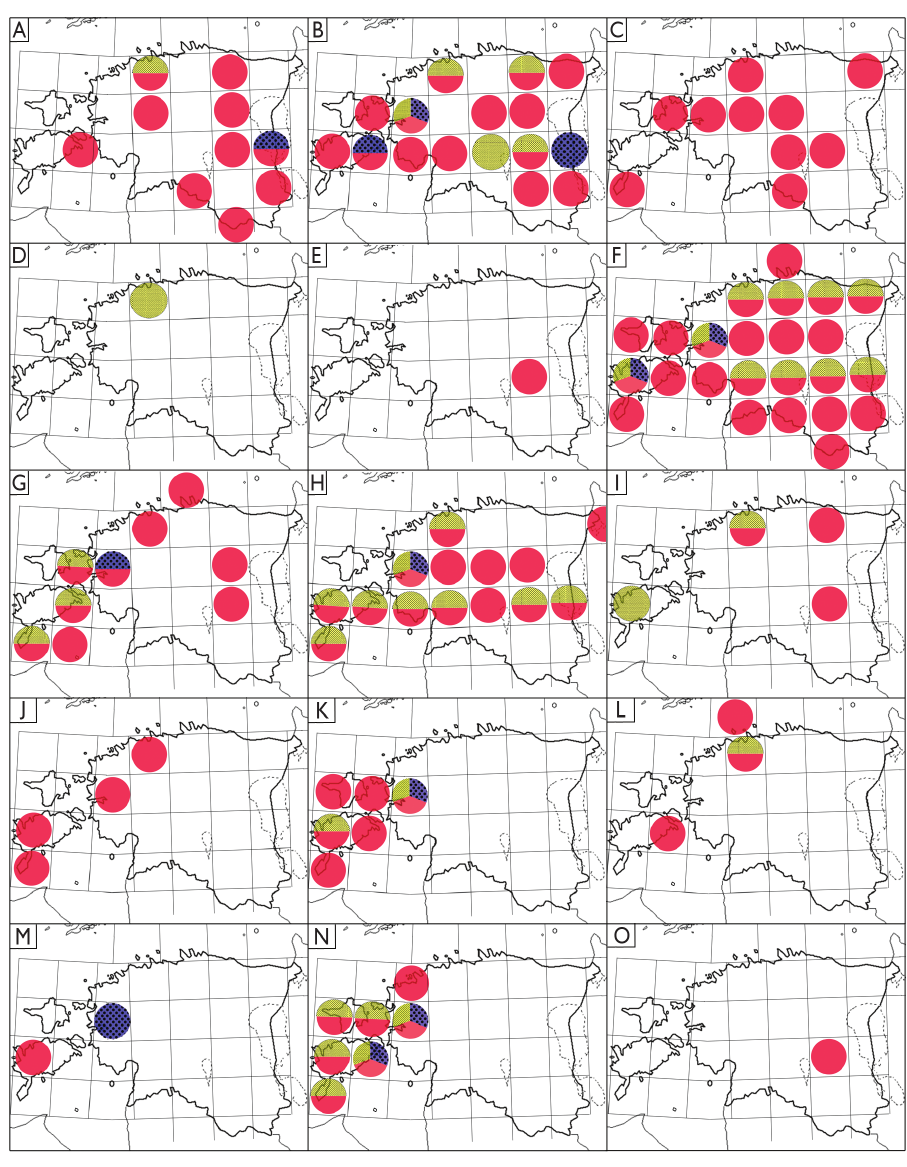
Figure 5. Distribution of Estonian Oniscidea. Red denotes studied specimens (1984–2020), blue = literature data 1970–1993, yellow = literature data 1927–1930 A Ligidium hypnorum B Trichoniscus pusillus C Hyloniscus riparius D Haplophthalmus mengii E Platyarthrus hoffmannseggii F Trachelipus rathkii G Porcellio scaber H Porcellio spinicornis I Cylisticus convexus J Oniscus asellus K Armadillidium opacum L Armadillidium pictum M Armadillidium pulchellum N Armadillidium zenckeri O Armadillidium vul- gare . Porcellionides pruinosus has been omitted since the published source mentions no specific